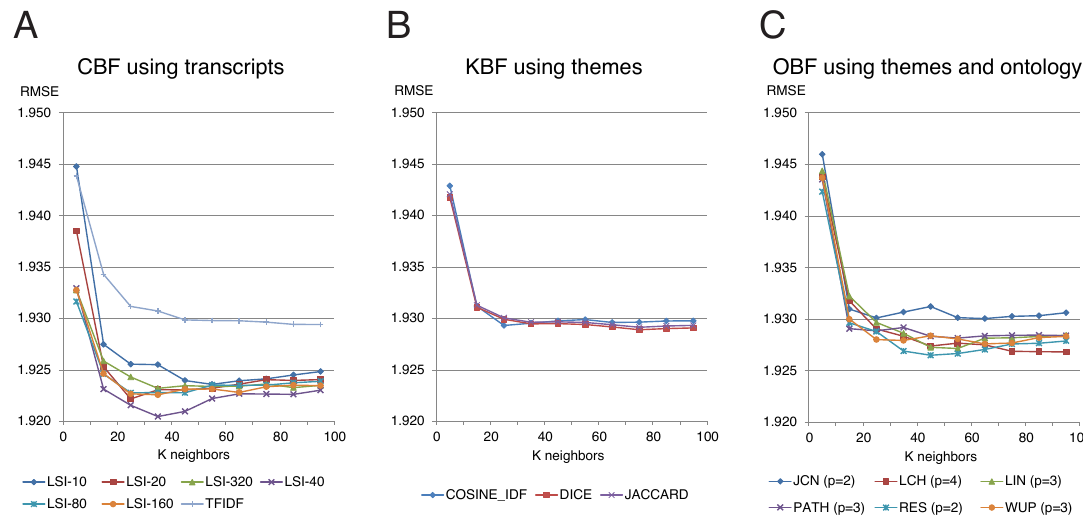
Figure 4. Results for the RSs (recommender systems) built using transcripts, themes, and the ontology of themes. ( A ) CBF using transcripts; ( B ) KBF using themes; ( C ) OBF using themes and